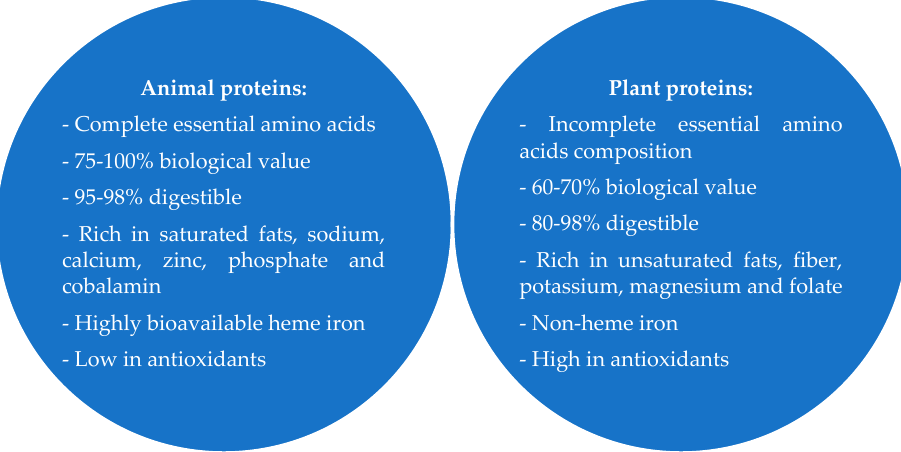
Figure 6. Unconventional and alternative protein sources are increasingly used in the food industry.